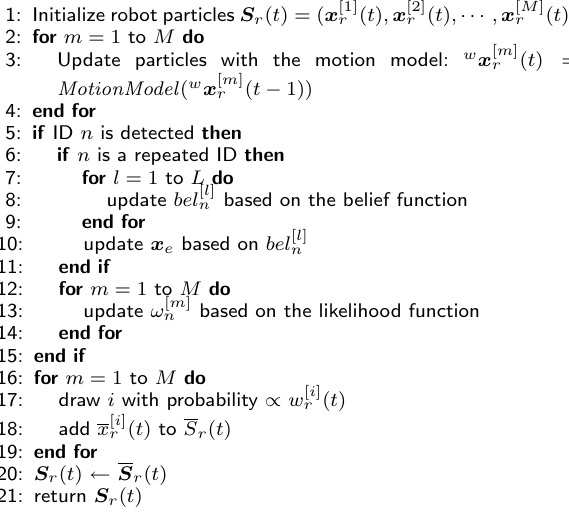
Algorithm 1 Self-localization based on the MCL method